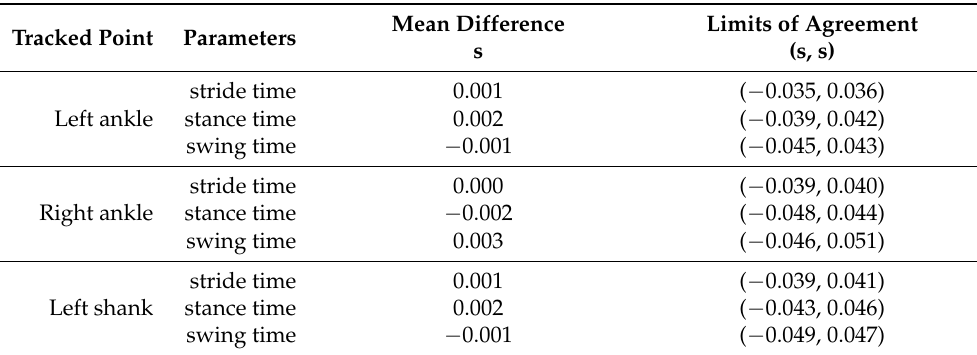
Table 7. Time agreement between the stride-specific